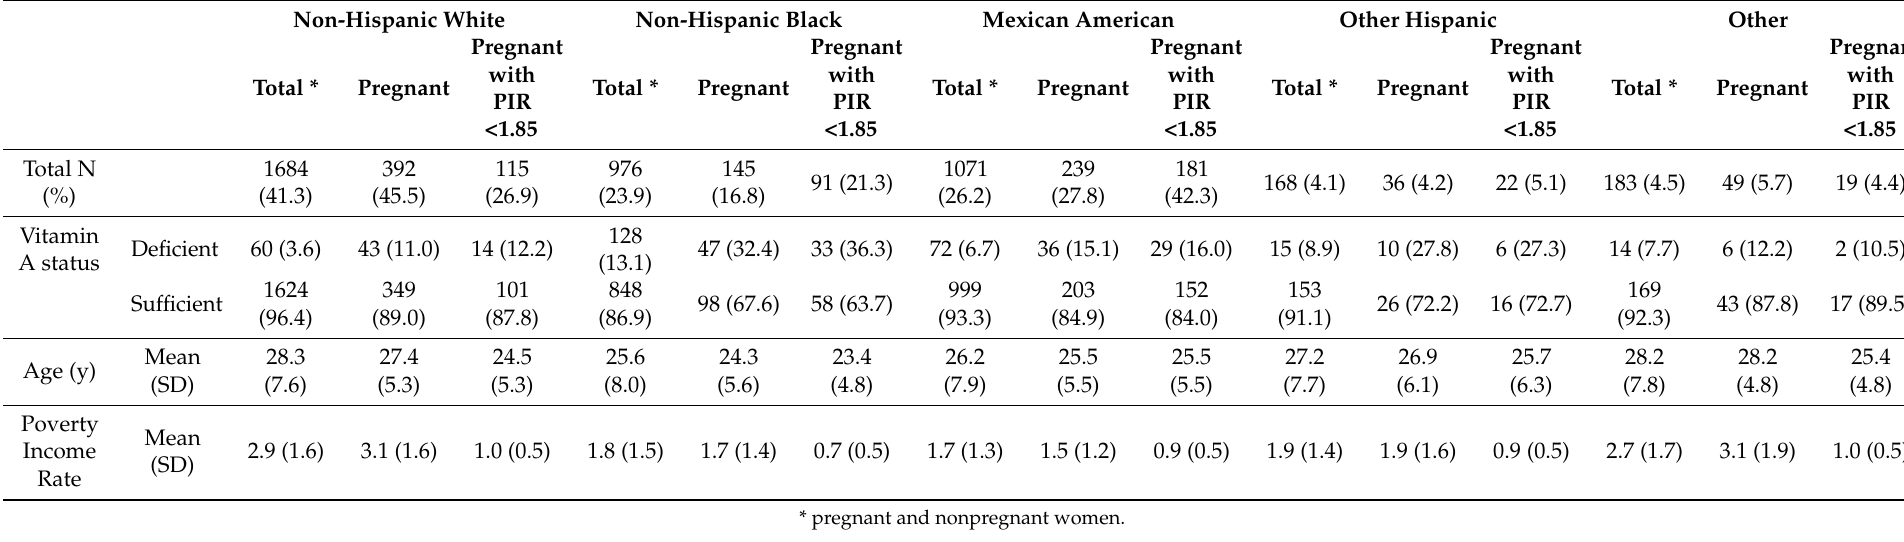
Table 2. VAD proportions of 4082 women in NHANES datasets by self-reported ethnic groups.